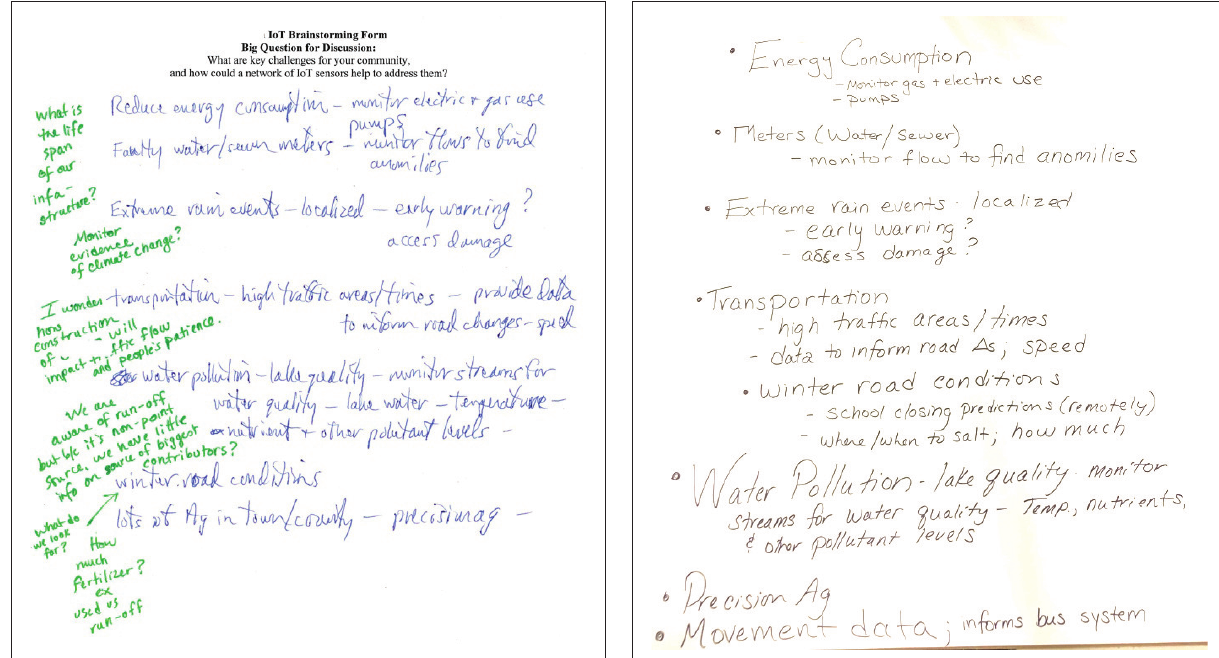
Figure 4. Brainstorming materials from participatory IoT workshops with community leaders: Individual brainstorming sheet with partner feedback (left) and group poster consolidating “use case” ideas produced from it